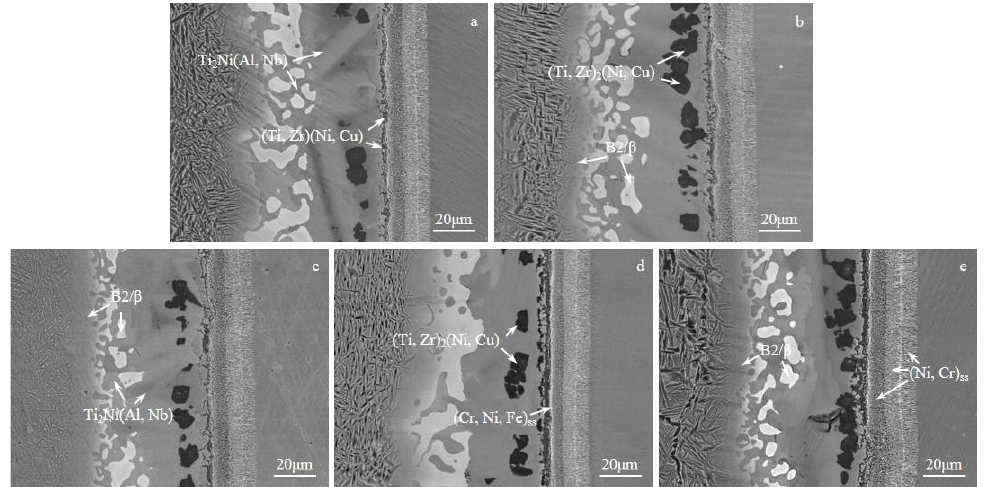
Figure 7. Microstructure of the Ti 2 AlNb/GH99 joints brazed at various holding time (1000 °C). ( a ) 4 min; ( b ) 6 min; ( c ) 8 min; ( d ) 10 min; ( e ) 12 min. ( a ) 4 min; ( b ) 6 min; ( c ) 8 min; ( d ) 10 min; ( e ) 12